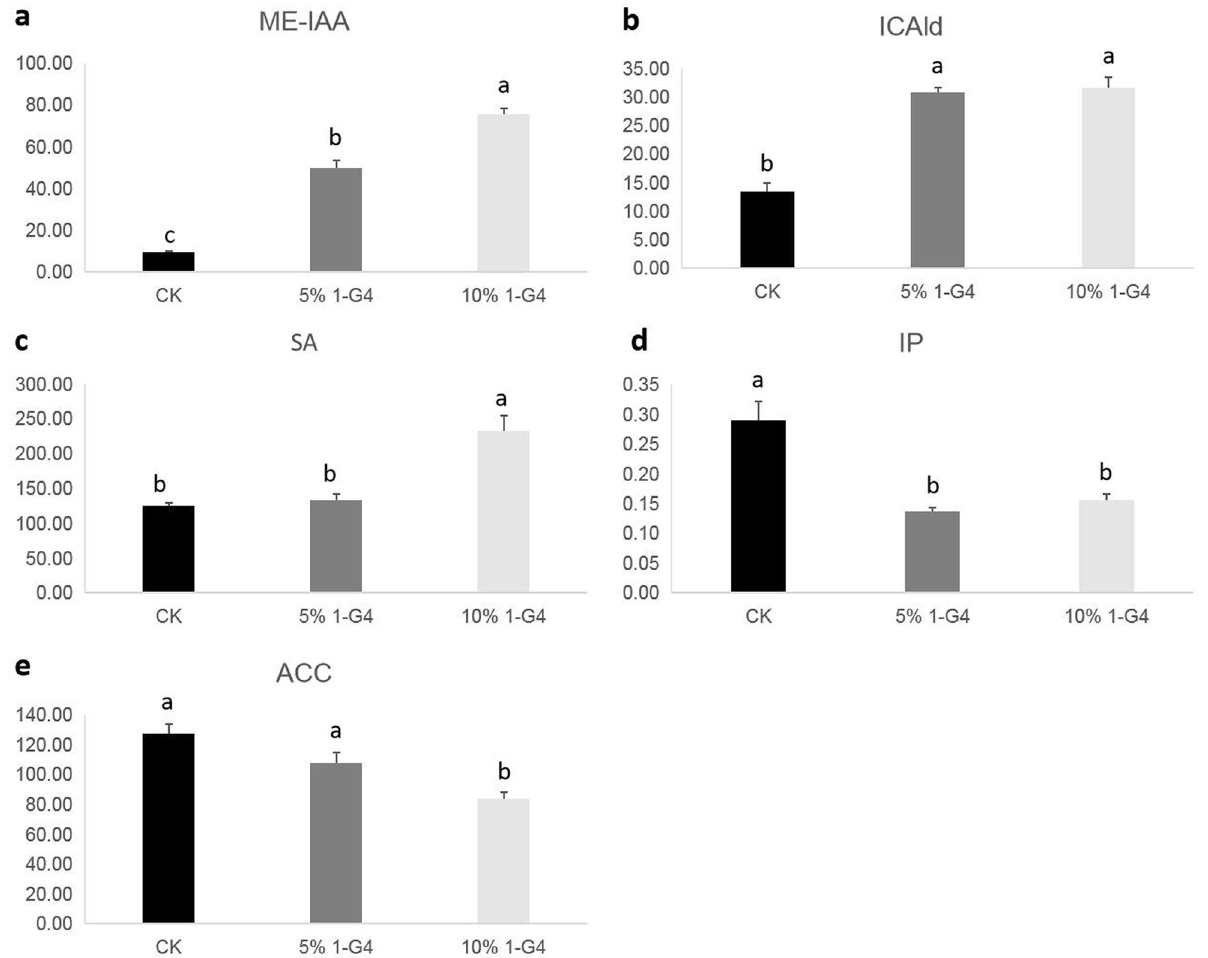
Figure 2. Changes in hormones under different concentrations of 1-G4 elicitor. ( a ) ME-IAA levels in control, 5% 1-G4 and 10% 1-G4 treated BS. ( b ) ICAld levels in control, 5% 1-G4 and 10% 1-G4 treated BS. ( c ) SA levels in control, 5% 1-G4 and 10% 1-G4 treated BS. ( d ) IP levels in control, 5% 1-G4 and 10% 1-G4 treated BS. ( e ) ACC levels in control, 5% 1-G4 and 10% 1-G4 treated